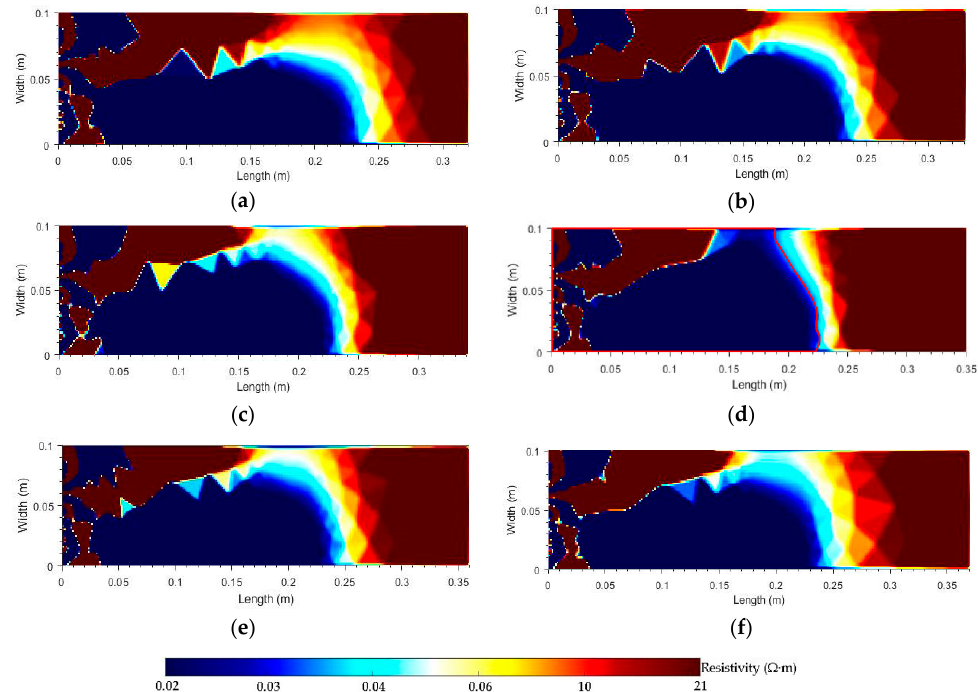
Figure 8. Inversion results of virtual grounding electrode at different distances when L = 0.2 m and I 0 = I 1 = 1 mA. ( a ) Is the inversion result when D = 0.32 m; ( b ) is the inversion result when D = 0.33 m; ( c ) is the inversion result when D = 0.34 m; ( d ) is the inversion result when D = 0.35 m; ( e ) is the inversion result when D = 0.36 m; ( f ) is the inversion result when D = 0.37 m.